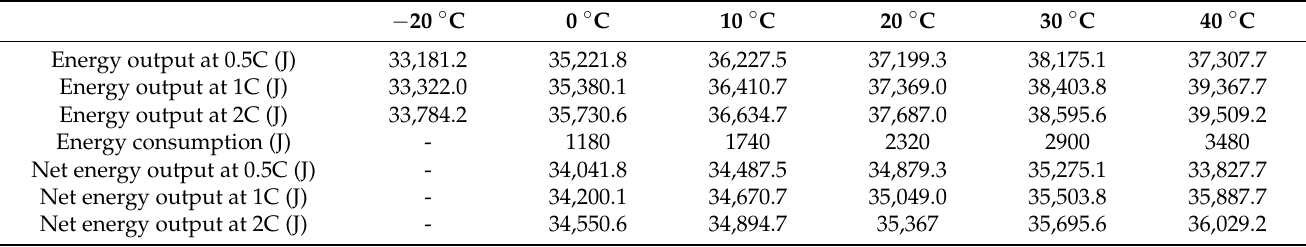
Table 4. Calculation results of